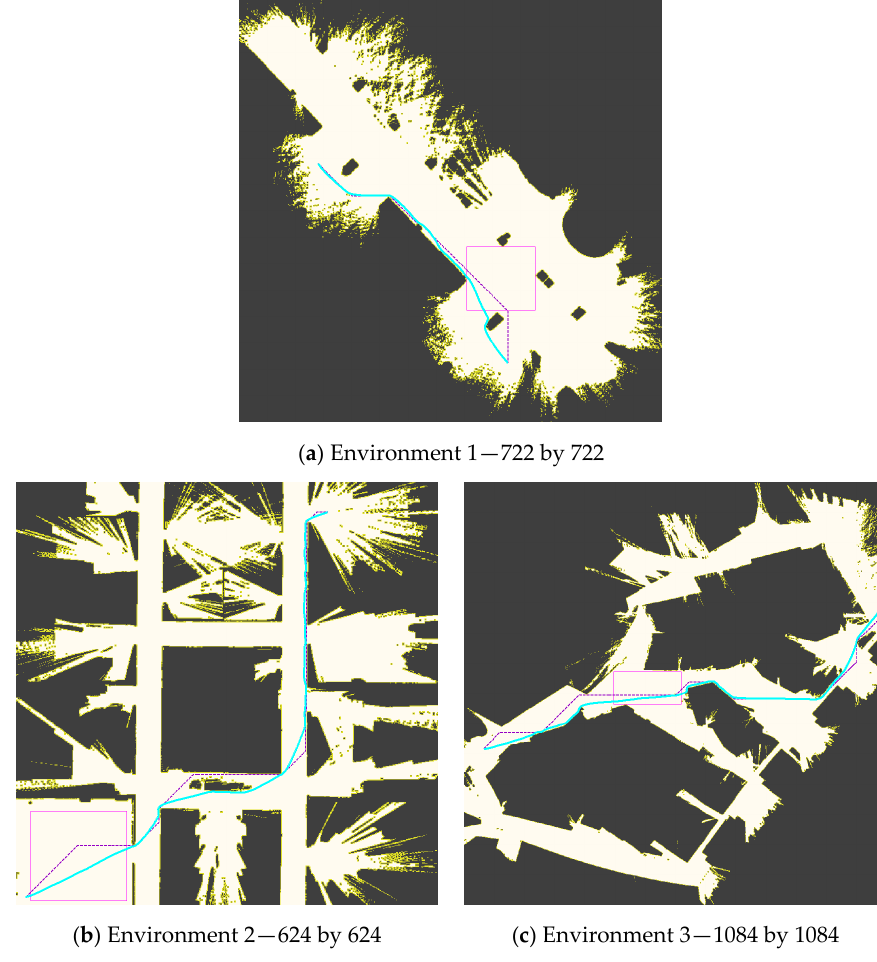
Figure 9. ( a – c ) Given the start position and the goal position, the purple line is the path planned by the Jump Point Search+ (Prune) (JPS+ (P)), and the blue line is the trajectory generated by JPS-IA3C. Black regions are unpassable, while light white regions are traversable for robots. Yellow regions close to obstacles denote warning areas. Moving obstacles appear in pink square areas, where there are 30 random moving obstacles.